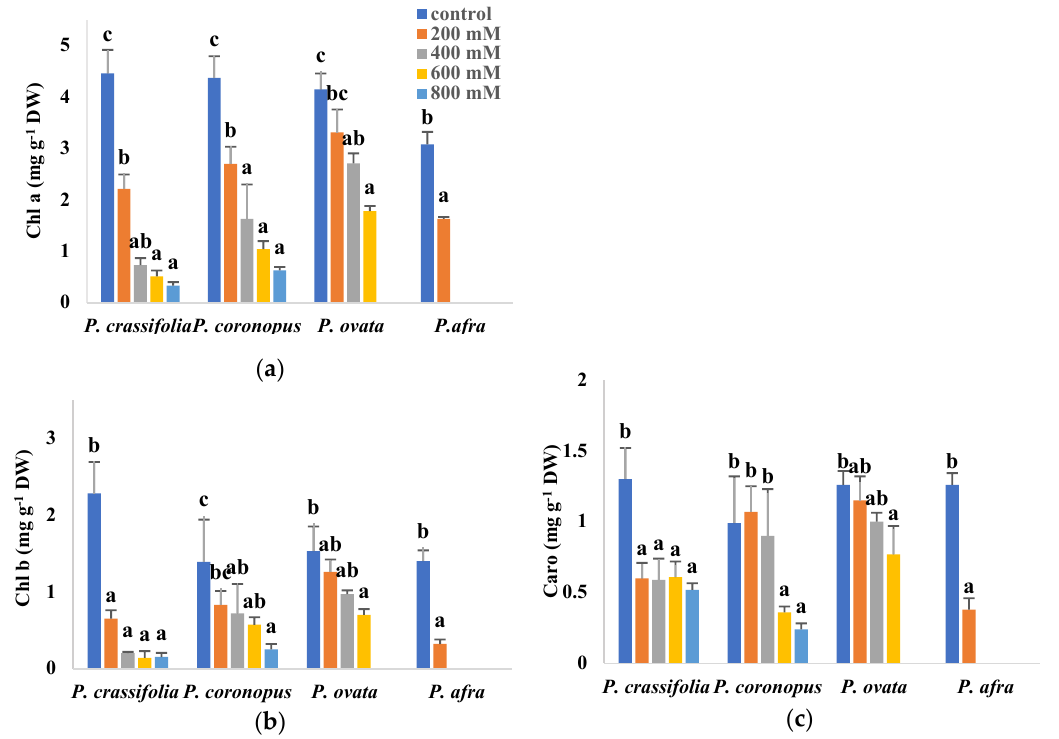
Figure 4. Chlorophyll a (Chl a) ( a ), chlorophyll b (Chl b) ( b ) and carotenoids (Caro) ( c ) contents in leaves of the four selected Plantago species, after four weeks of treatment with the indicated NaCl concentrations. The values shown are means ± SE ( n = 5). For each species, different letters over the bars indicate significant differences between treatments, according to the Tukey test ( p < 0.5).